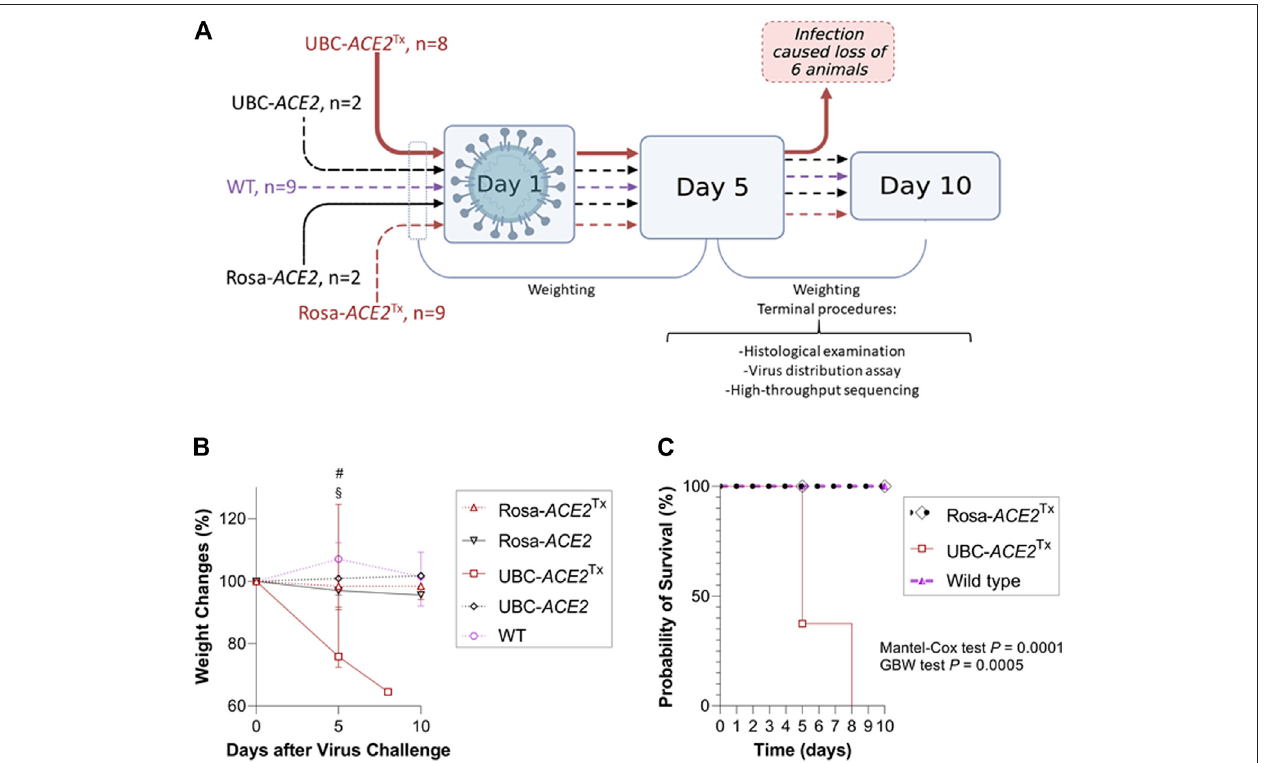
FIGURE1| EvaluationofSARS-CoV-2sensitivityinmicewithCre-dependenthuman(h) ACE2 expression. (A) Graphicalrepresentationoftheexperimentaldesign. All the mice in the UBC- ACE2 Tx group died before the 10th day (Created with BioRender.com). (B) Dynamics of weight change after virus challenge; (C) Kaplan – Meier curve showing decreased survival in infected UBC- ACE2 Tx